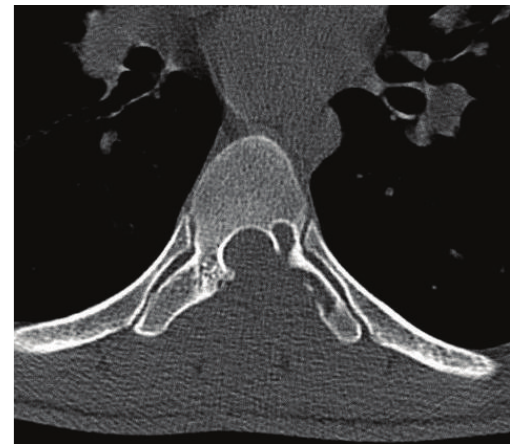
Figure 3: Axial CT scan showing soft tissue mass eroding through lamina and encroaching on thecal sac. There are no foci of calcifica- tions.